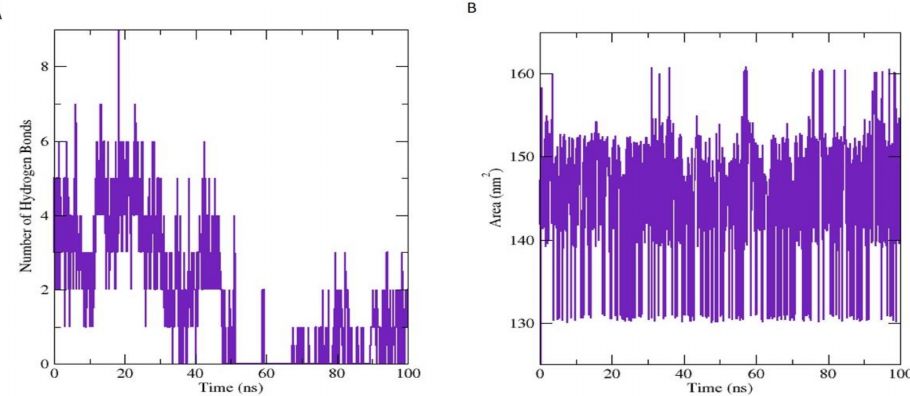
Figure 8. The number of hydrogen bonds of COX-2 inhibitor (Methyl 7-abieten-18-oate) complex until 0–100 ns ( A ). Y-axis shows the calculated number of hydrogen bonds, while X-axis shows variation in timespan during molecular dynamic simulations. While solvent-accessible surface area (SASA) of COX-2 protein ( B ). Y-axis shows the thermodynamic calculations of changes in COX-2 inhibitor complex surface area in unit nanometers square (nm 2 ) (Å), while X-axis shows the residue’s stability time during 0–100